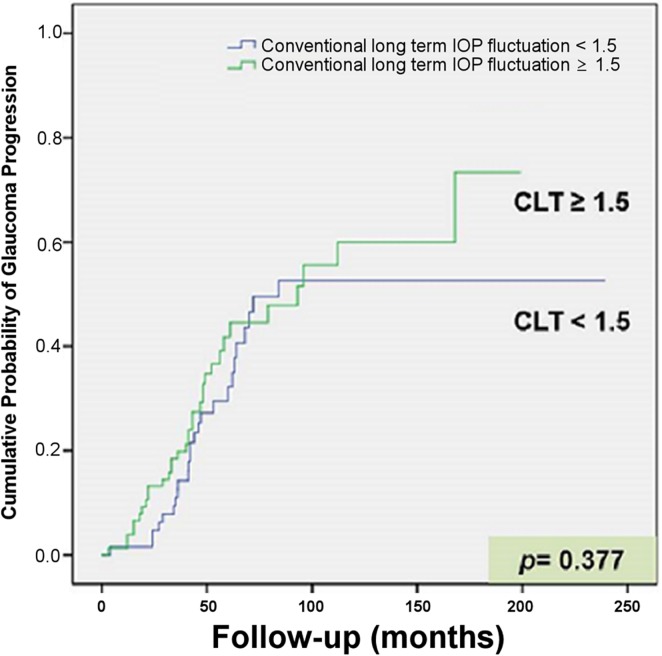
Kaplan-Meier curve showing the cumulative probability of glaucoma progression in patients with NTG.With conventional long-term IOP variation (CLT), no difference in the cumulative probability of glaucoma progression was detected between the groups with a standard deviation of IOP of >1.5 and <1.5 mmHg (P = 0.377, log-rank test).